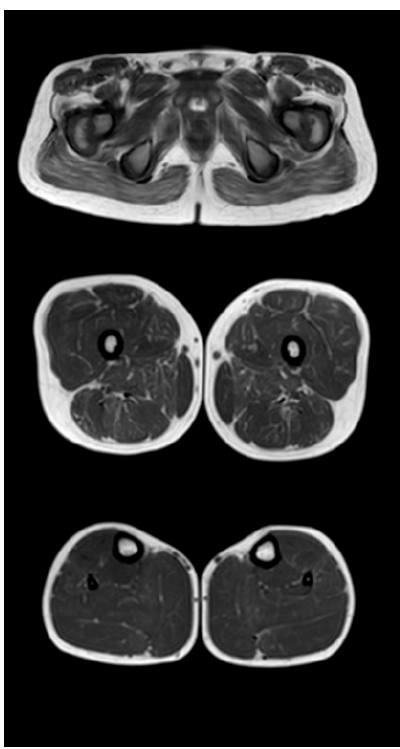
Figure 3. Pattern of involvement of the muscles of the lower extremities in a patient at an early outpatient stage of the disease (6.1 years). From top to bottom: the pelvic level, the femoral level, and the level of the legs.